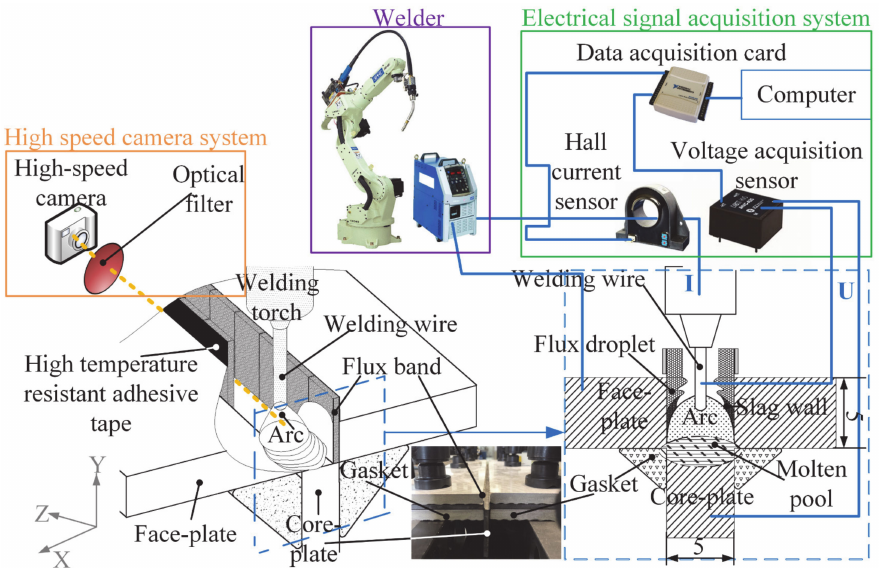
Figure 1. Schematic diagram of flux bands constricting arc (FBCA)